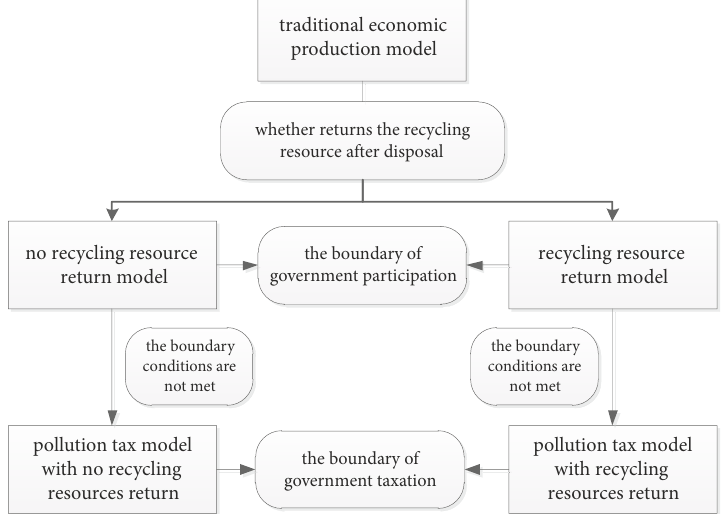
Figure 2. Relationship between the